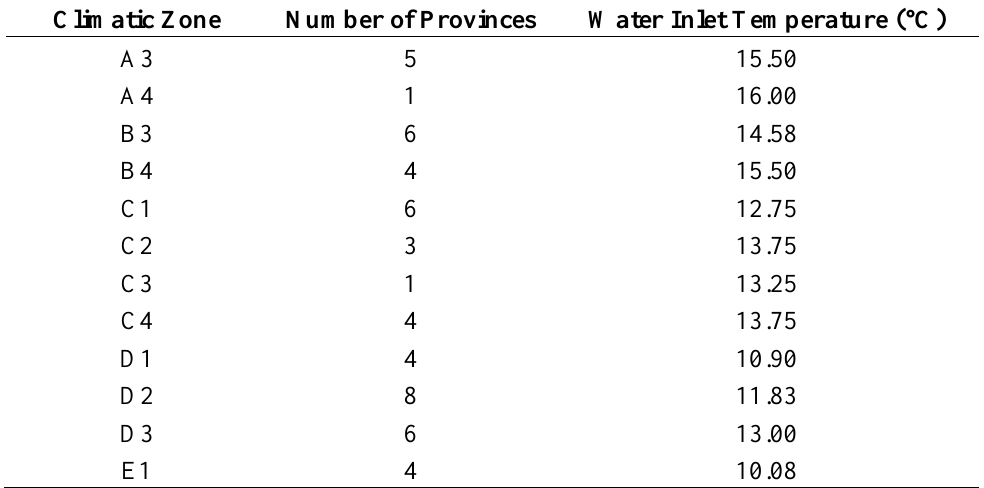
Table 4. Average annual inlet temperature of water regarding the climatic zone in Spain. Climatic